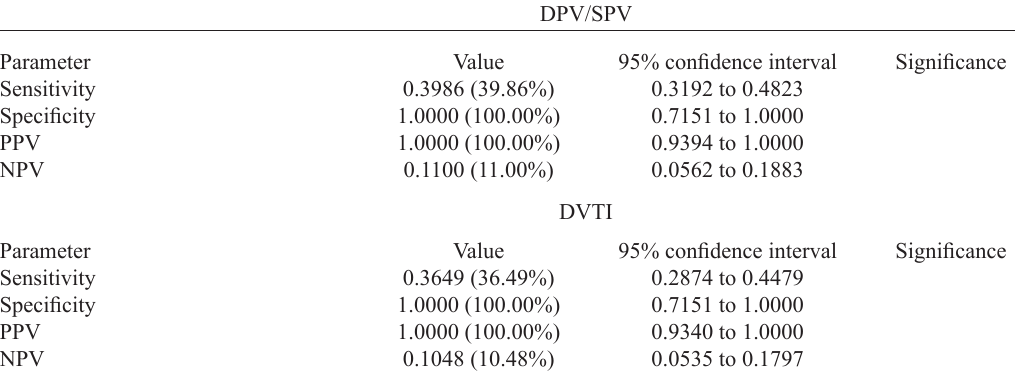
Table 4. Validation criteria for using DPV/SPV to detect composite graft patency, with DF as the gold standard. Sensitivity, specificity, positive predictive value (PPV), negative predictive value (NPV), and the associated 95% confidence intervals were